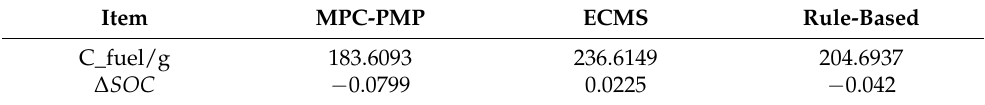
Table 4. Fuel consumption and SOC fluctuation of each